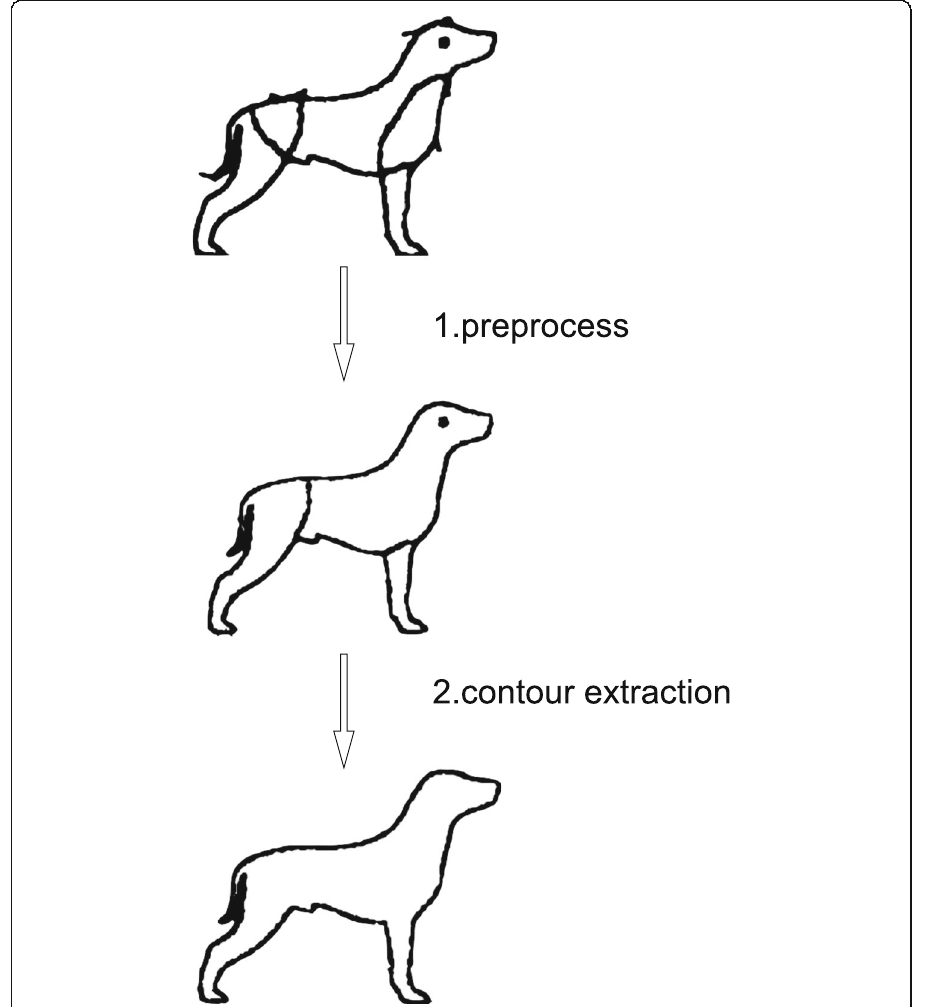
Fig. 2 The process of a hand-drawn sketch contour